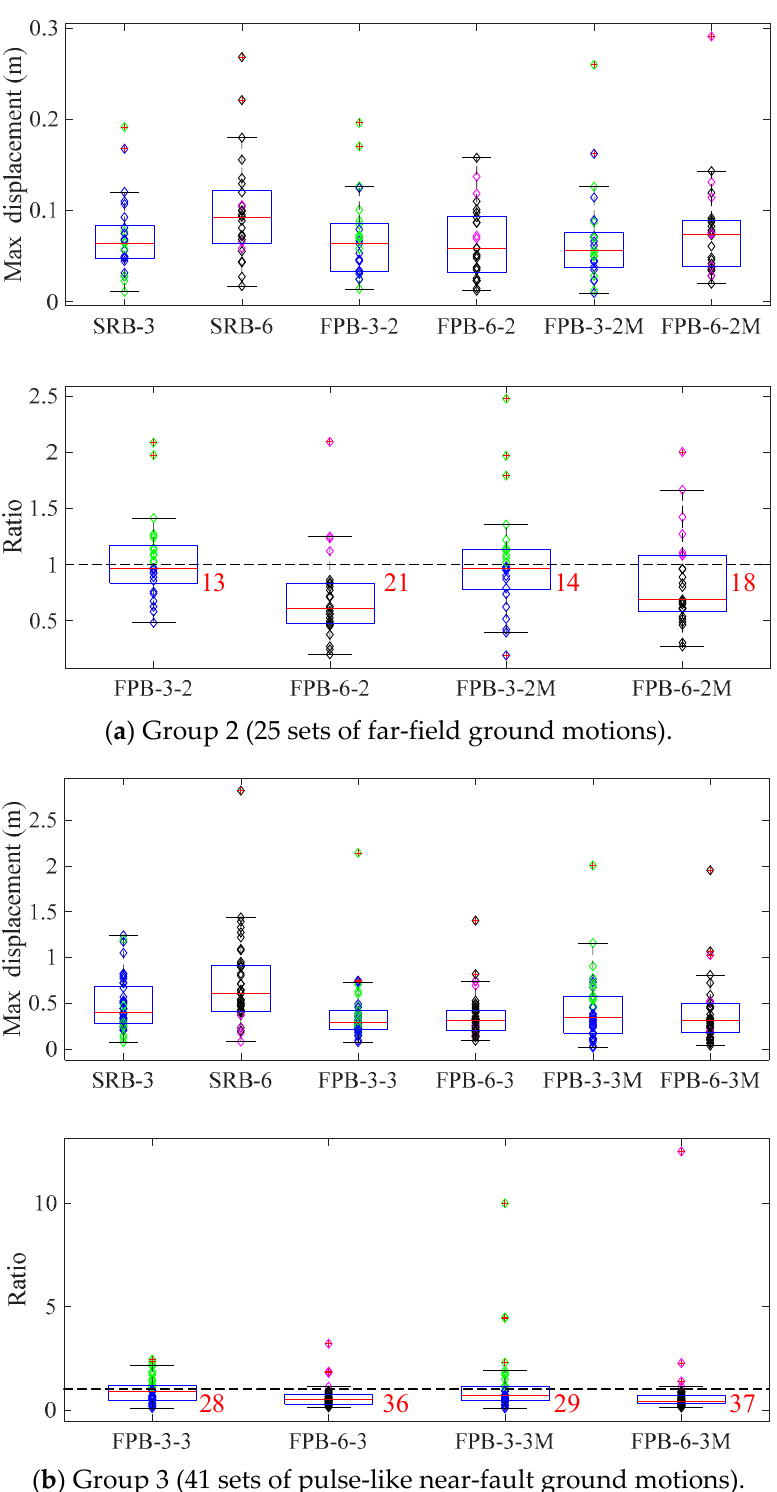
Figure 13. Comparisons of maximum horizontal displacement responses of SRBs and FPBs subjected to di ff erent ground motions.